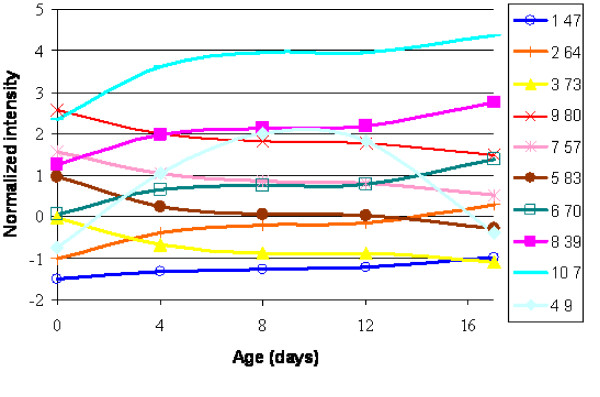
Expected cDNA expression trajectories for each of the 10 clusters identified in the mellifera (M) data set using a clustering approach. The legend indicates the group number and the estimated number of cDNAs per group.